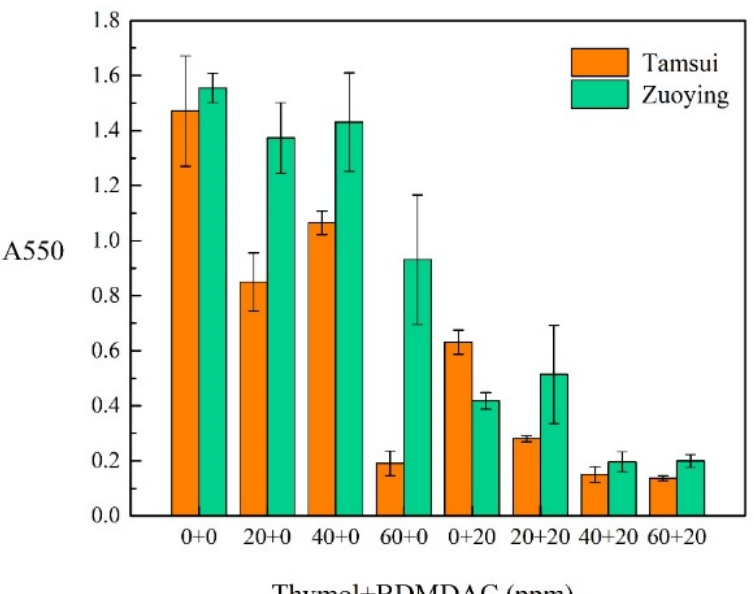
Figure 5. Treatments of varying concentrations of biocides to inhibit biofilm formation in the Tamsui and Zuoying